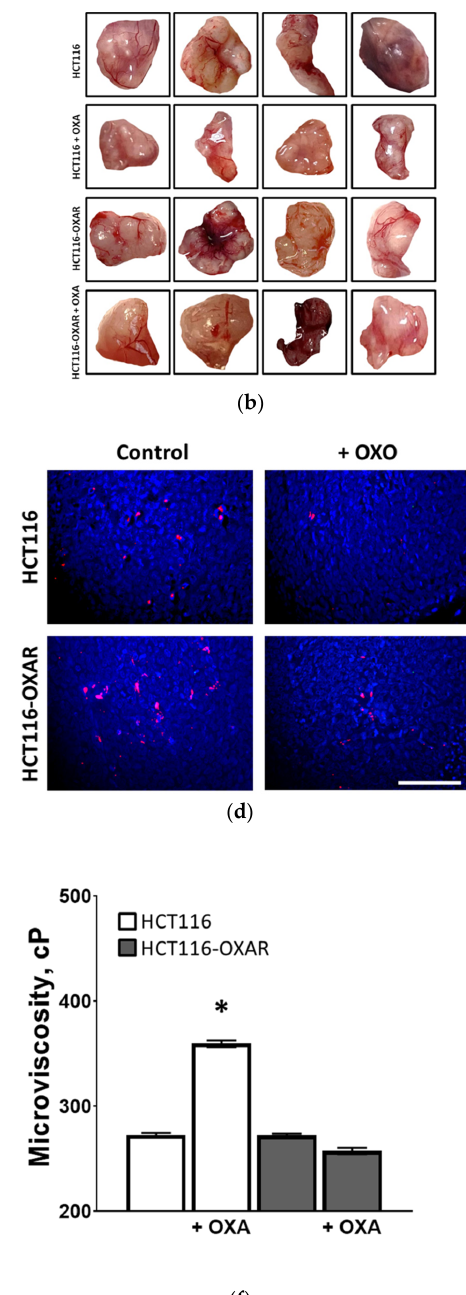
samples are color coded.